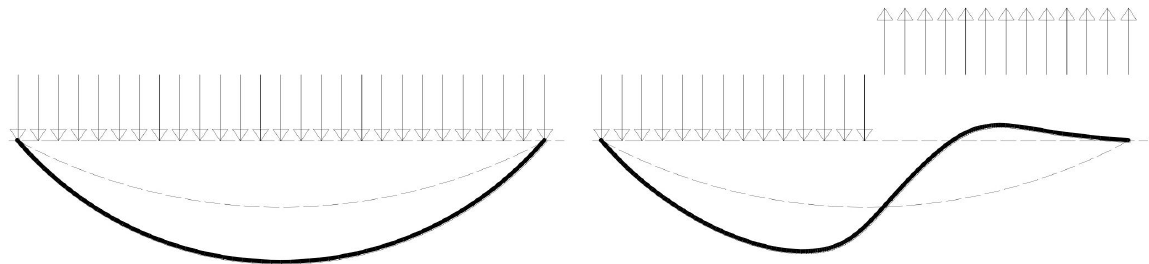
Figure 19: Cable deformation under uniformly and non-uniformly load distribution